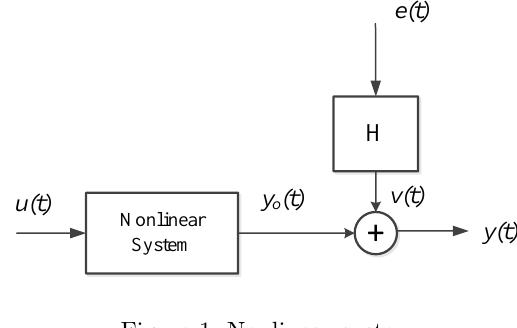
Figure 1: Nonlinear